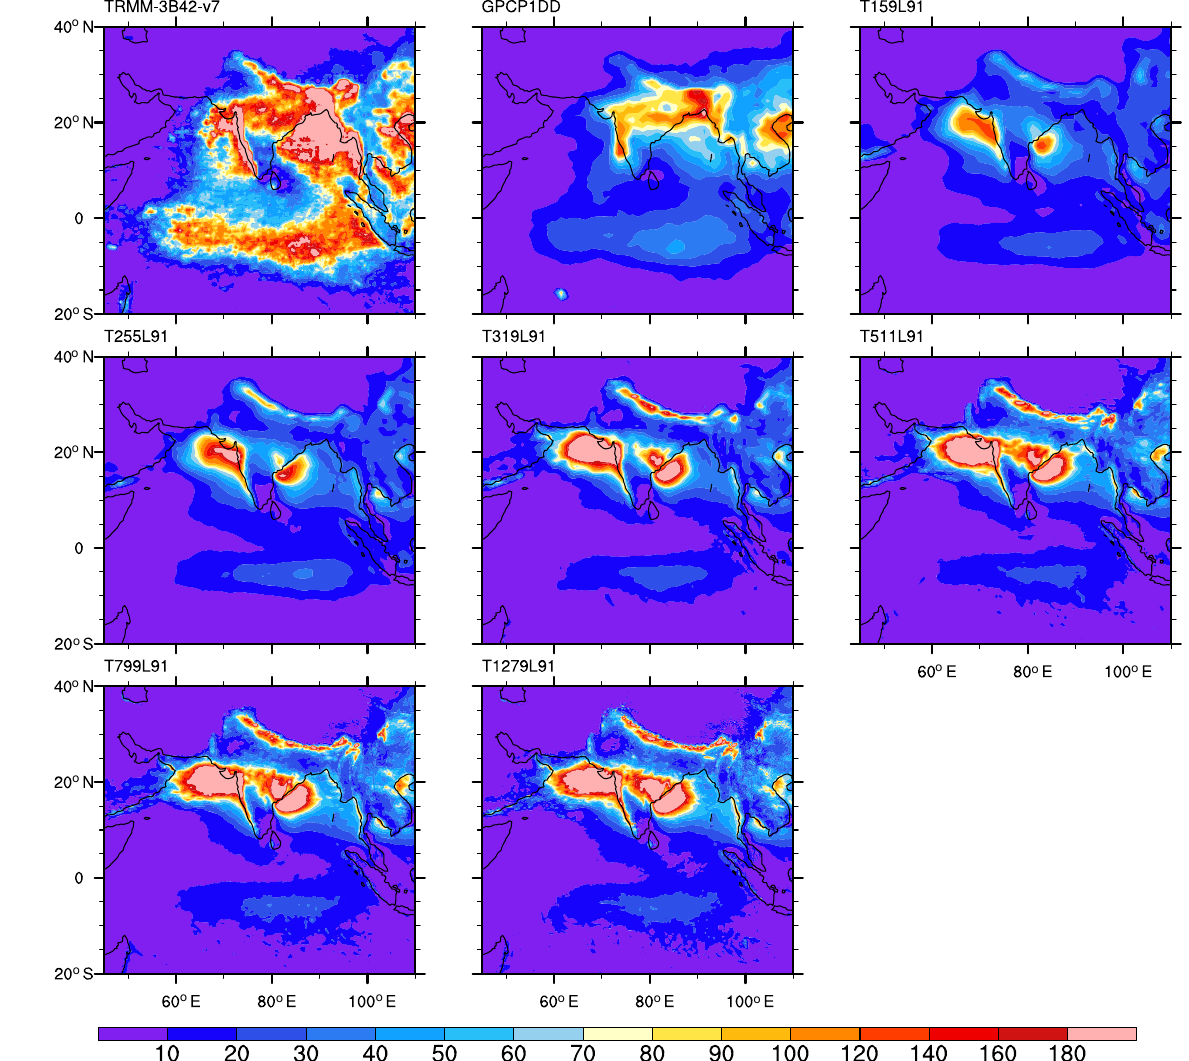
Figure 13. The 3–10 day band-pass-filtered JJAS precipitation variance for TRMM (0.25 ◦ × 0.25 ◦ ), GPCP-1DD (1 ◦ × 1 ◦ ), and the T159, T255, T319, T511, T799, and T1279 EC-Earth simulations (mm 2 day − 2